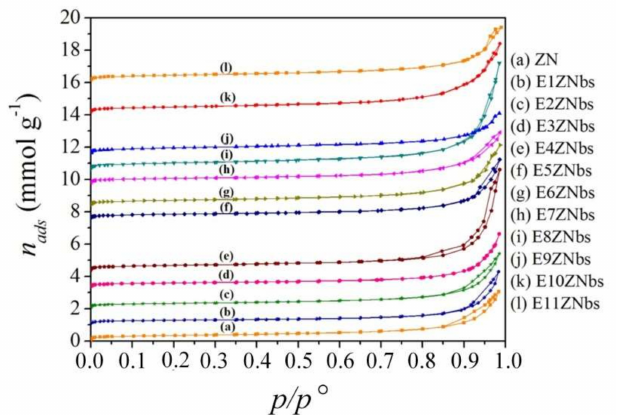
Figure 5. N 2 adsorption and desorption isotherms at 77 K for the zeolites before and after basic treatments. The isotherms of E1ZNbs, E2ZNbs, E3ZNbs, E4ZNbs, E5ZNbs, E6ZNbs, E7ZNbs, E9ZNbs, E10ZNbs, and E12ZNbs samples were vertically offset by 1, 2, 3.3, 4.3, 7.5, 8.3, 9.7, 10.5, 11.5, 14, and 16 mmol · g − 1 , respectively.